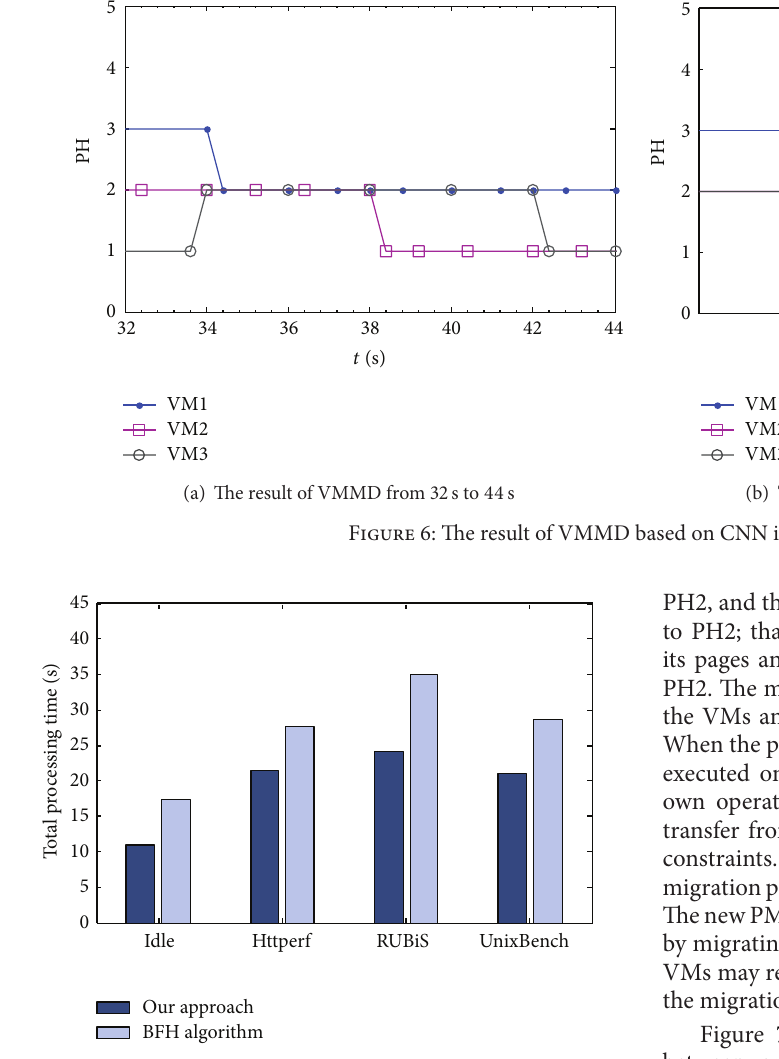
Figure 7: Total processing time of VMMD for different